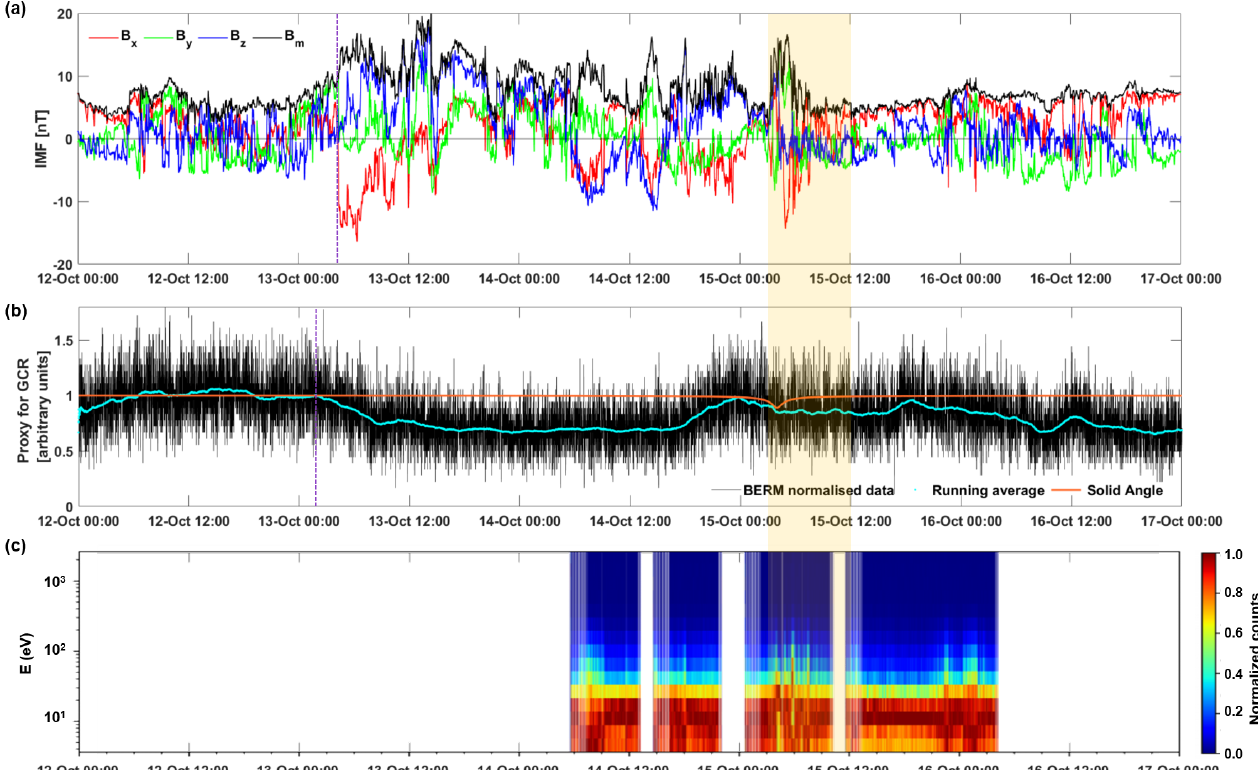
Figure 13. Solar wind observations. (a) Magnetic field observations from MPO-MAG in VSO, (b) proxy for galactic cosmic ray (GCR) observations from BERM and part of the BepiColombo solid angle not shadowed by Venus, and (c) energy electron spectrograms from MEA1. The arrival time of the coronal mass ejection (CME) is marked with a vertical purple dashed line and the Venus transit (same period of the observations of this paper) is marked with a yellowish